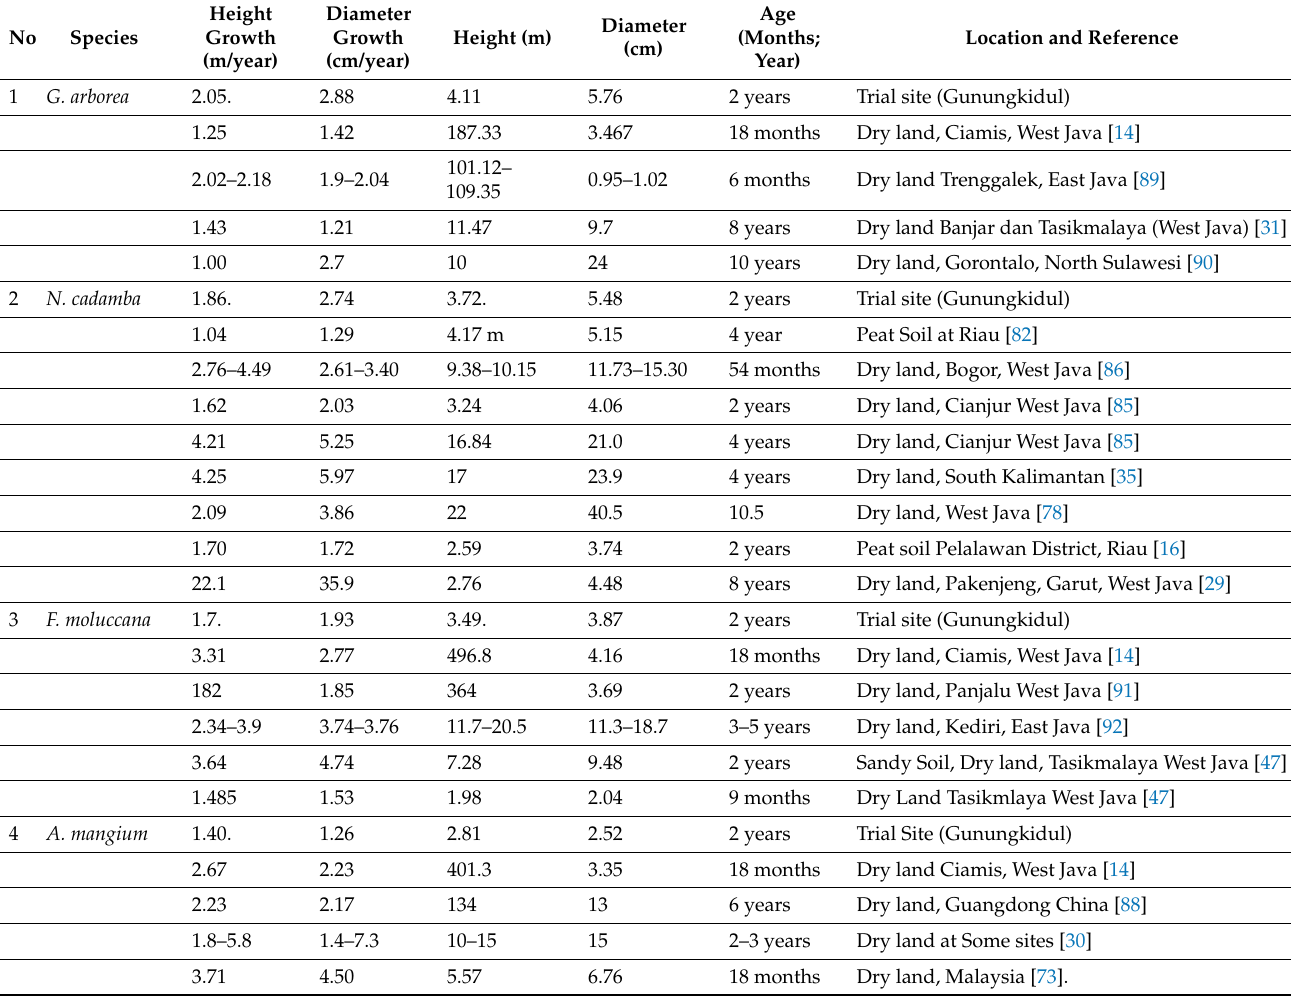
Table 4. Height and diameter growth of the 4 fast growing tree species in some